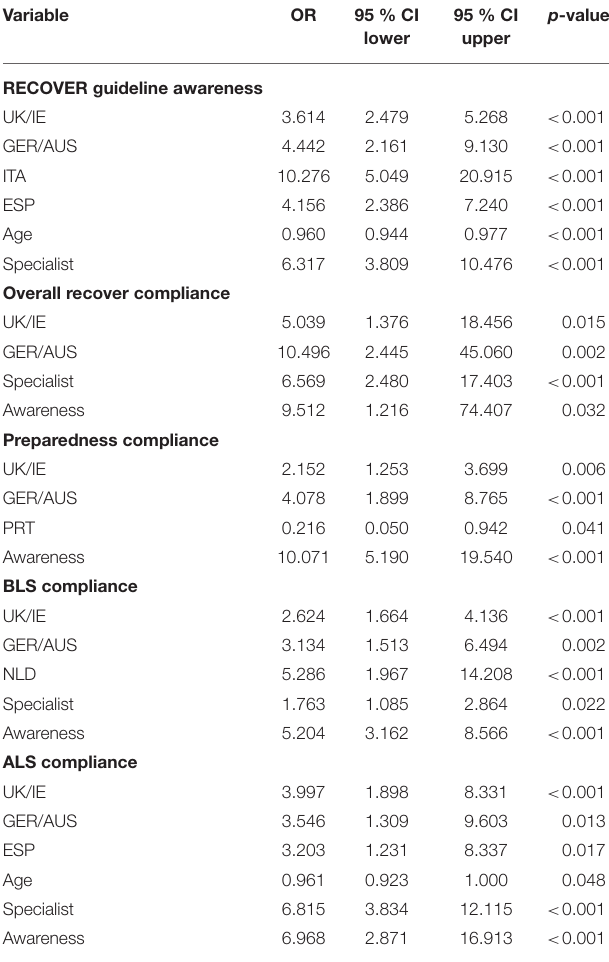
TABLE 3 | Factors significantly associated with RECOVER guideline awareness and ascribed compliance with CPR preparedness, BLS execution, ALS execution, and overall RECOVER compliance in multivariable logistic regression